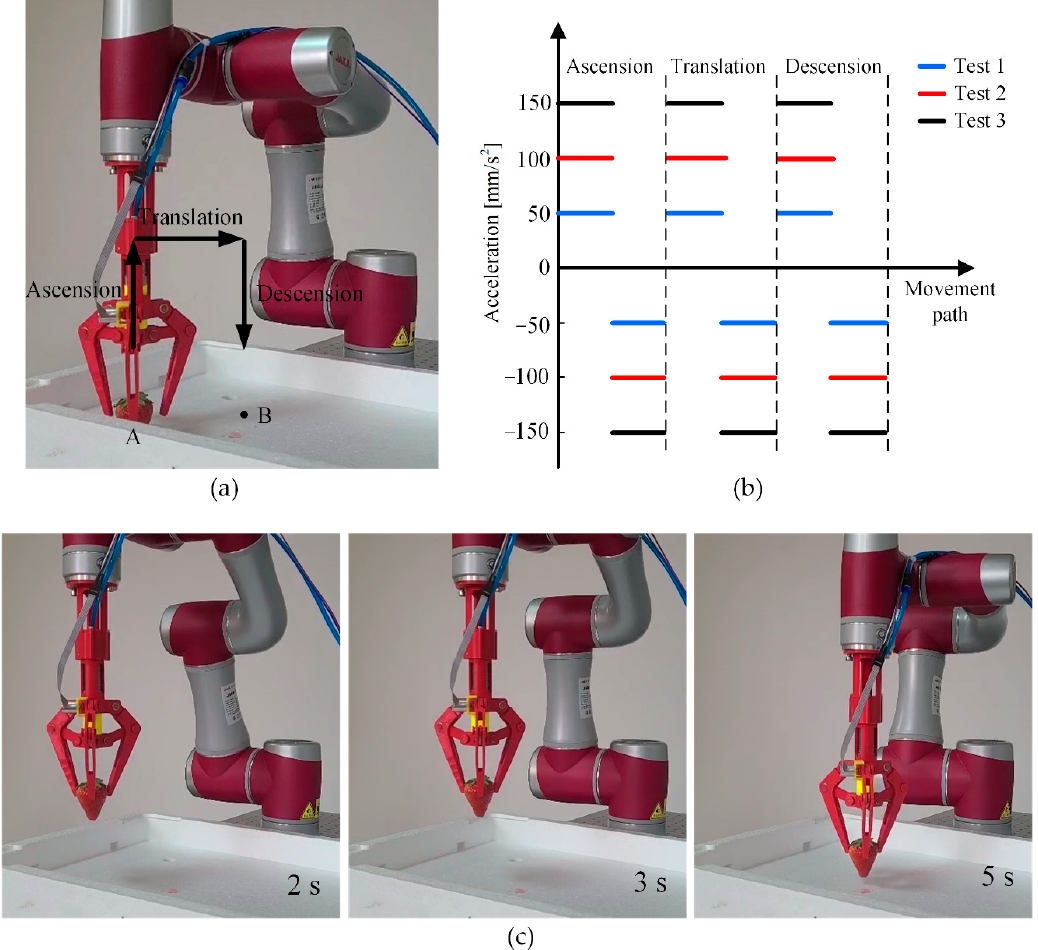
Figure 14. Dynamic gripping test of the gripper. ( a ) The movement path of the gripper in the dynamic gripping test was divided into ascension, translation, and descension, ( b ) the gripper had two movement states at each movement path, ( c ) The image snapshots of the dynamic gripping of the gripper under different times at the acceleration of 150 mm/s 2